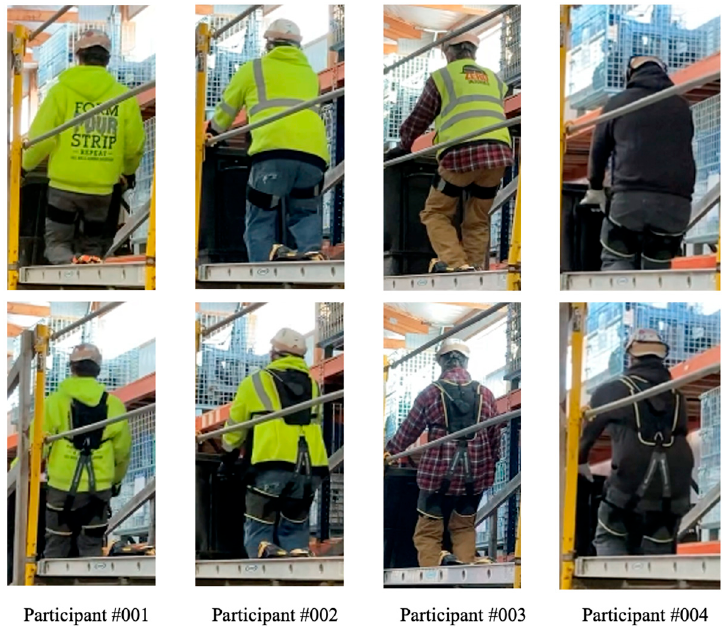
Figure 18. Participants with and without HeroWear